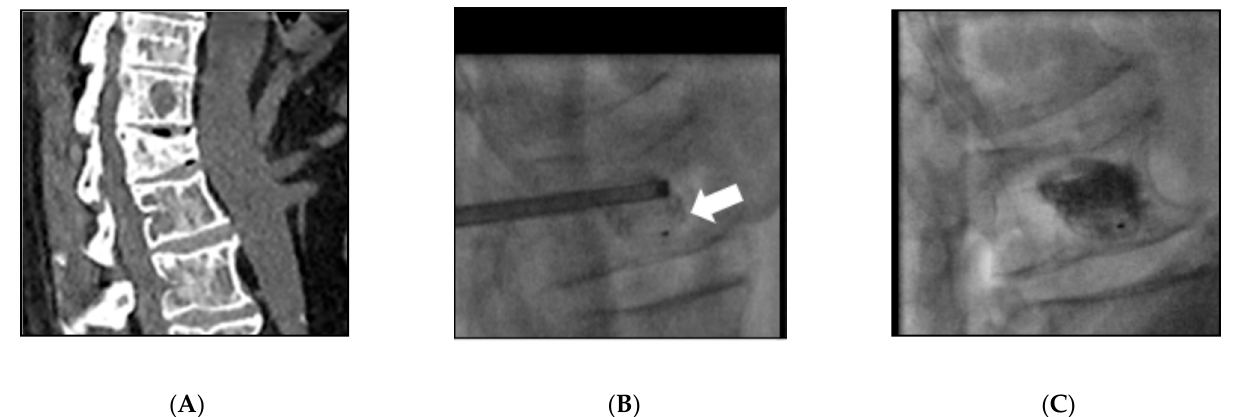
Figure 3. KIVA ® implantation in L2 in a 57-year-old man (Patient 16) with myeloma. ( A ) sagittal reconstruction of CT scan. ( B ) The device (arrow) was inserted into the vertebral body under fluoroscopy via a monolateral transpedicular approach. ( C ) After deployment of the device, the cement was injected via injection.